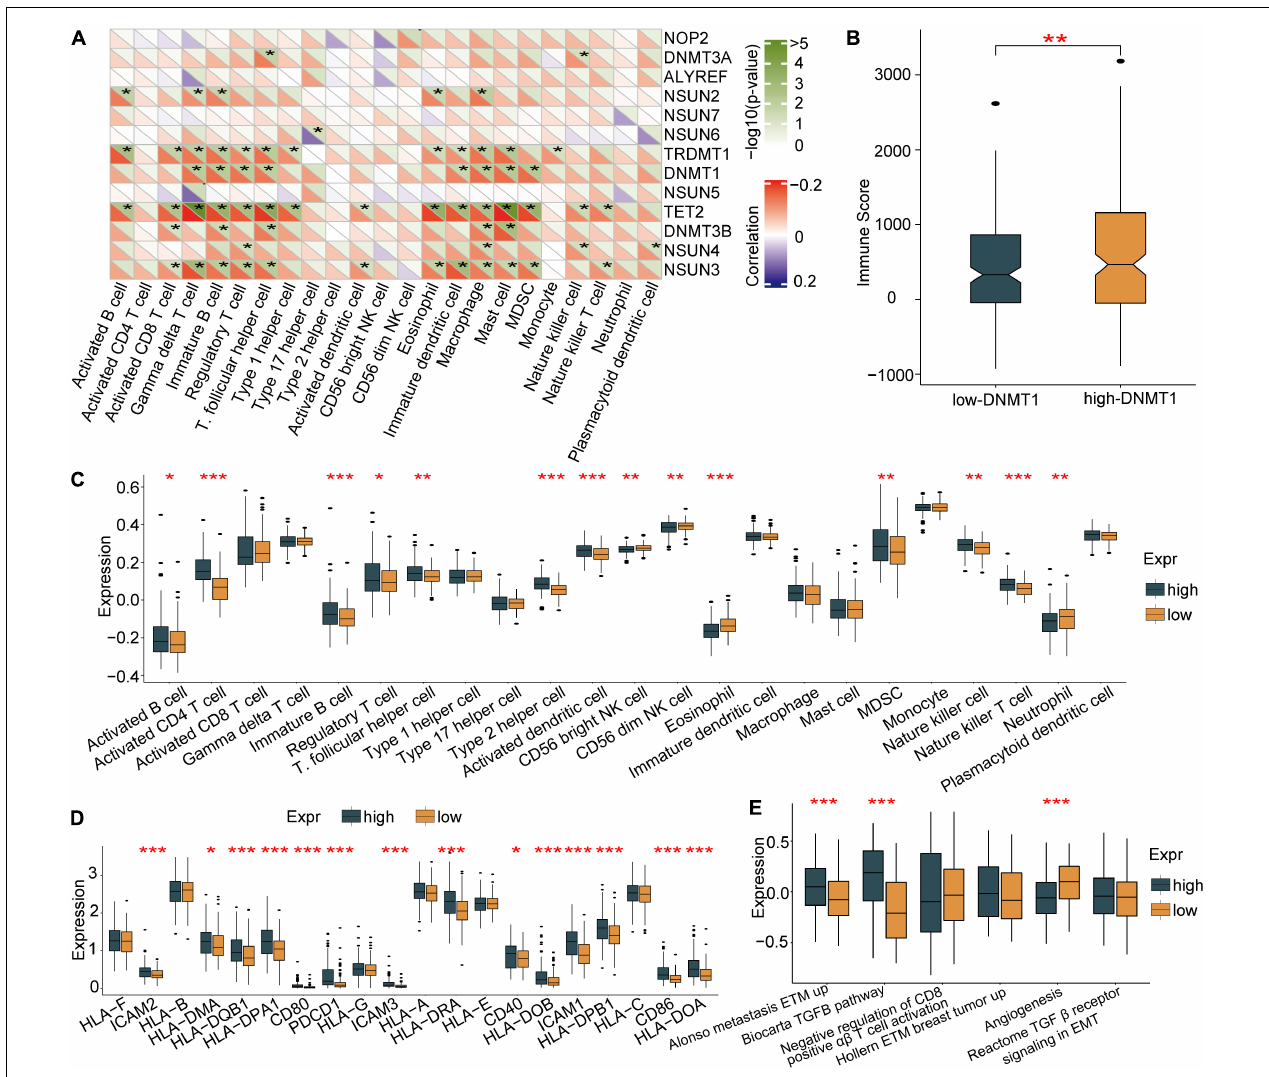
FIGURE 4 | Association of TME-infiltrating cells with the m 5 C regulator of DNMT1. (A) Correlation between m 5 C regulators and different immune cells using Spearman analysis. (B) Immune scores of the low DNMT1 group and the high DNMT1 group. (C) Comparison of the abundance of immune-infiltrating cells in the low DNMT1 group and high DNMT1 group. (D) Correlation between m 5 C regulators and the activation of dendritic cells. (E) High DNMT1 expression shows significant enhancement of the immune-activated pathway. * p < 0.05, ** p < 0.01, *** p <